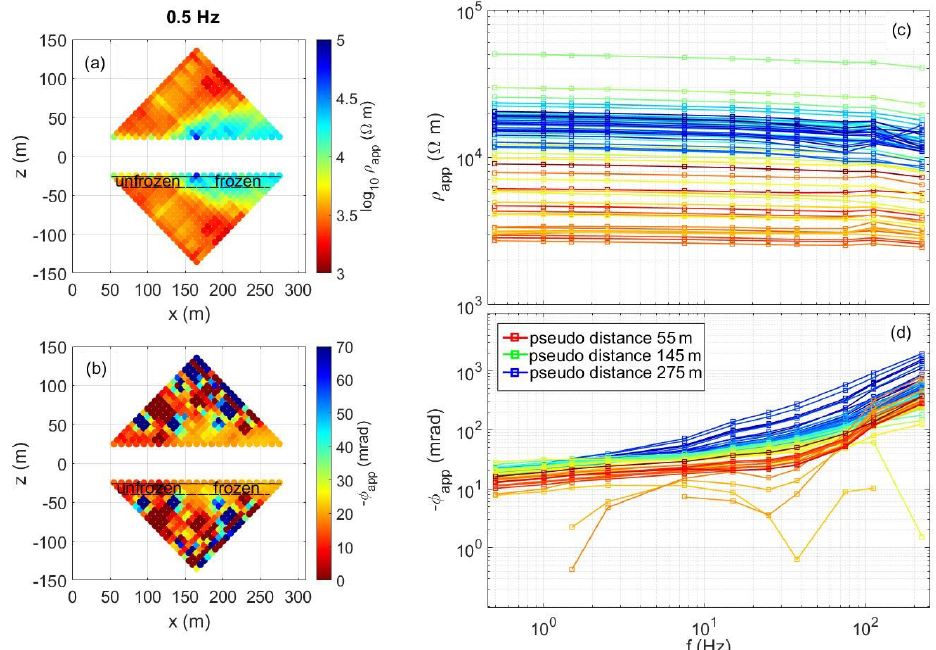
Figure 5. Visualization of the frequency dependence in the electrical impedance measurements collected along profile V2. Impedance magnitude values are converted to apparent resistivity (a) and phase (b) values. The spectral response (c, d) is plotted for level 2 and 3 (i.e. 20 and 30m electrode separation between current and potential dipoles, between the dashed lines) from north (downslope) to south (upslope) corresponding to the transition from unfrozen to frozen subsurface